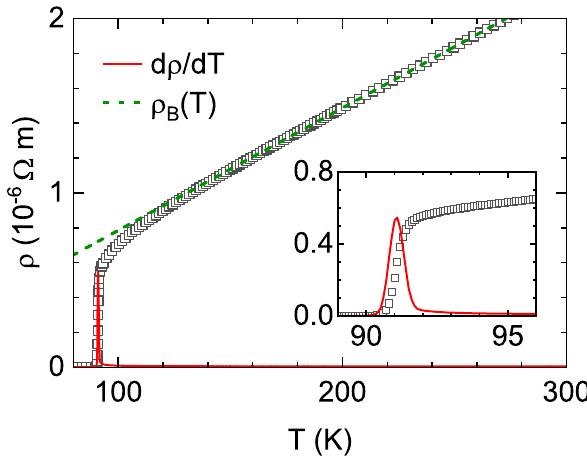
Fig. 1 In-plane resistivity data 𝜌 ab ( T ) (black squares) used for the analyses in this work, corresponding to measurements of Ref. [19] in a high quality, optimally doped YBCO thin film. The normal state background resistivity 𝜌 B ( T ) (dashed green line) was estimated by using a linear fit of the data between 200 and 250 K (2.2–2.7 T c ), well into the strange metal regime of the normal state (i.e., above T onset ≈ 1.7 T c ) . A sharp superconducting transition occurs at T = 91.1K, with FWHM Δ T c = 0.6 K, as evidenced by the deriva- tive of data (solid red line), also shown in the inset. See Ref. [19] for more details